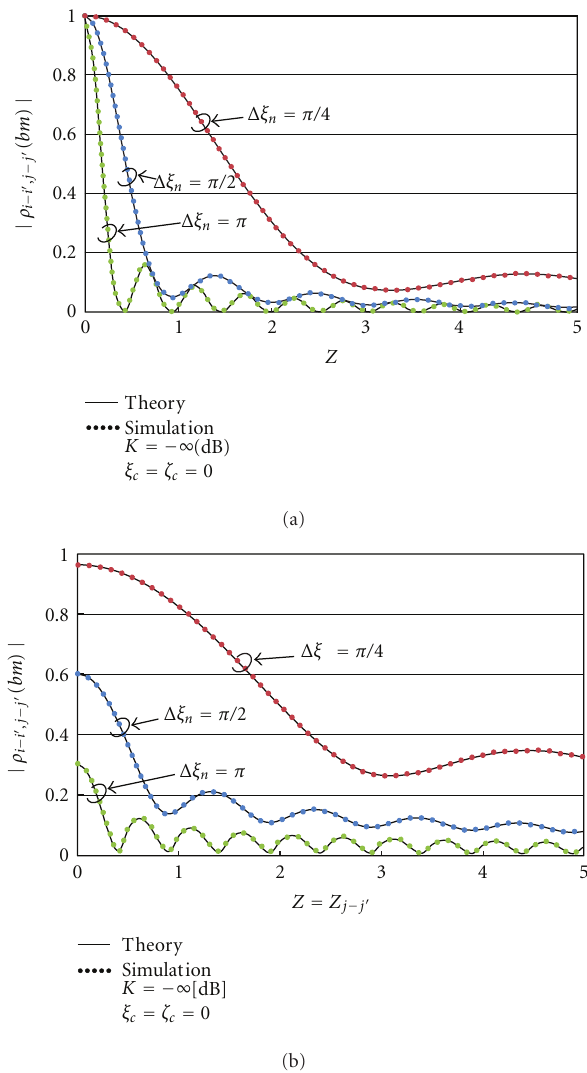
Figure 5: Correlation of both-side channel (uniform-uniform distribution). (a) Z = Z i − i (cid:2) = Z j − j (cid:2) . (b) Z i − i (cid:2) = 0 . 5. keeping z i − i (cid:2) = 0 . 5. So the simulated value is less than 0.3 whenever z is small since we kept z i − i (cid:2) = 0 . 5. The theoretical value from (10) was also calculated; the theoretical and simulated values agree